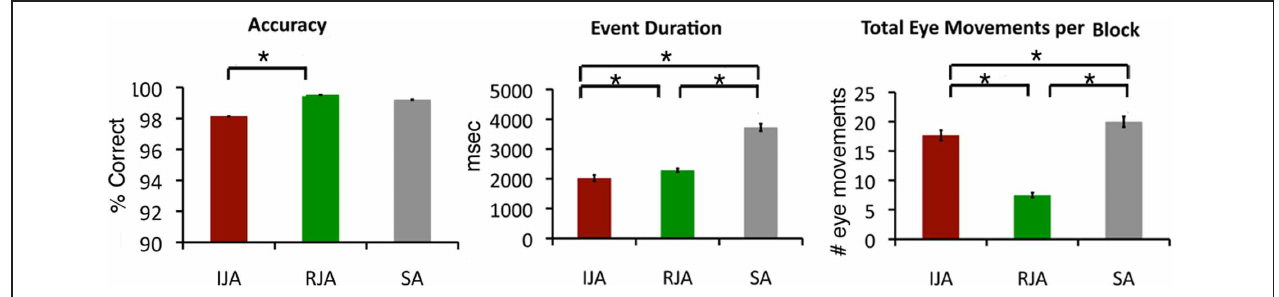
Event duration was defined as the average length of time spent in joint (or solo) attention on the mouse. Number of eye movements indicates the average total number of eye movements toward a corner of the screen in each block (5